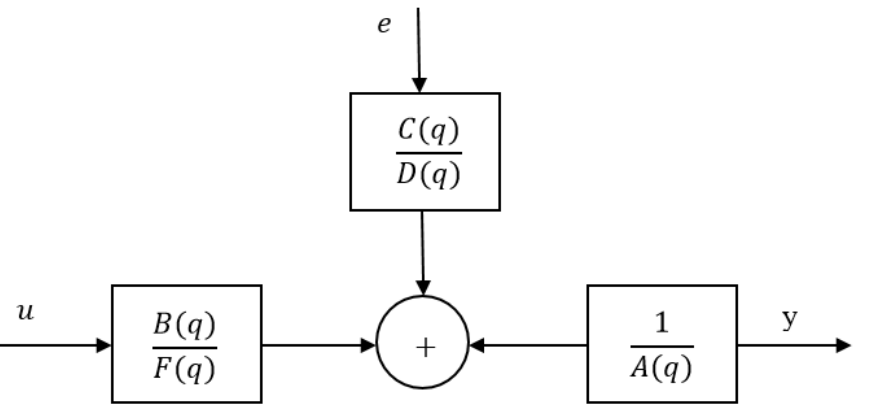
Figure 1. The schematic diagram of a generalized typical discrete-time linear mathematical model [34].